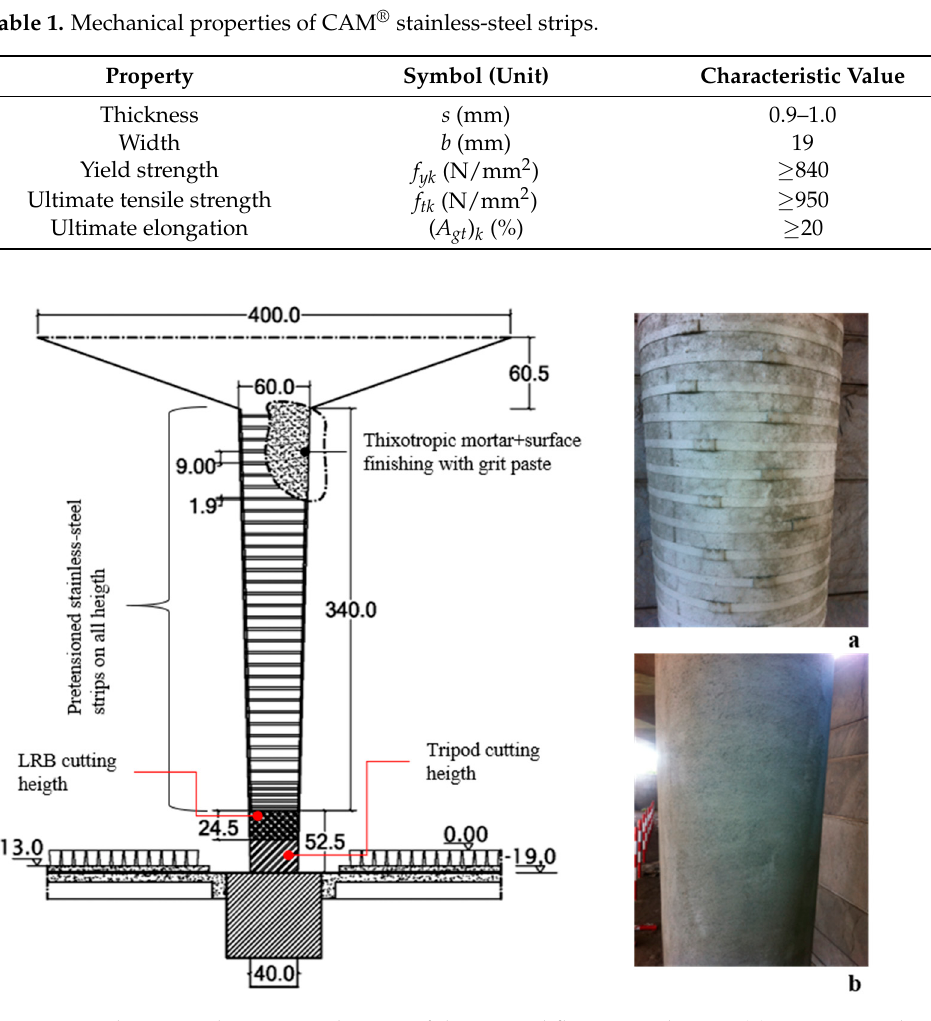
Figure 8. Preliminary shear strengthening of the ground floor RC columns: ( a ) pretensioned strips after applying a grip- ping layer, and ( b ) view of the strengthened column after applying the plaster (all dimensions in cm).